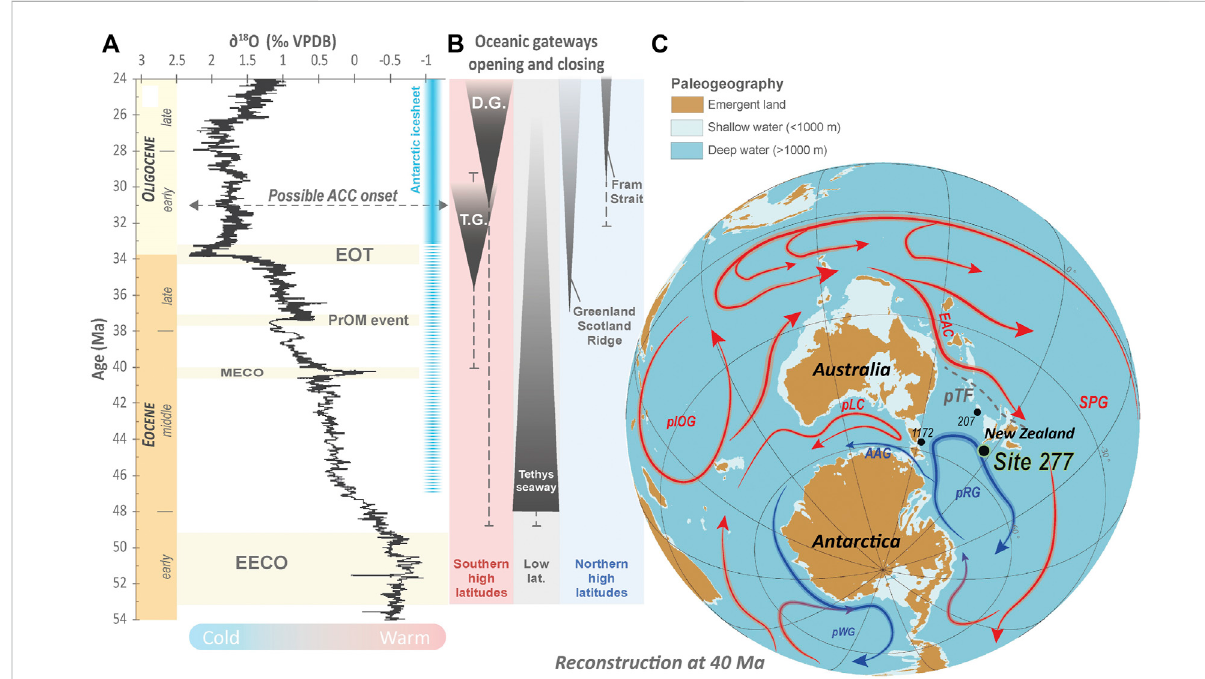
FIGURE 1 (A) Temporal evolutionof theglobal benthic foraminifera δ 18 O recordsand main climate events along theEocene-Oligoceneinterval (from the GTS2020 by Gradstein (2020)). Possible occurrences of Antarctica ice-cap are also represented after Zachos et al. (2001). Possible ACC (Antarctic Circumpolar Current) onset is from Scher et al. (2015) and Hodel et al. (2021). (B) Opening and closing timing of main oceanic gateways during the Eocene-Oligocene (from Straume et al., 2020). (C) Paleogeographic and paleobathymetric representation of the southern hemisphere at the Oligocene, ca.30 Ma (paleobathymetricdata from Straumeetal., 2020 andmodelbuilt using theGPlate software, Mülleretal., 2018).Paleocurrents are represented based on Nelson and Cooke, (2001), Huber et al. (2004), Stickley et al. (2004), Bijl et al. (2009, Sijp et al. (2011); Pascher et al. (2015), Hines et al. (2017), Houben et al. (2019); Ladant et al. (2020), Straume et al. (2020), Hodel et al. (2021), Shepherd et al. (2021) and Sauermilch et al. (2021). Abbreviations:EOT, Eocene-Oligocene Transition; PrOM event, Priabonian Oxygen isotopeMaximumevent; MECO, MiddleEocene Climate Optimum; EECO, Early Eocene Climate Optimum; T.G, Tasmanian Gateway; D.G, Drake Passage Gateway; pIOG, proto-Indian Ocean Gyre;